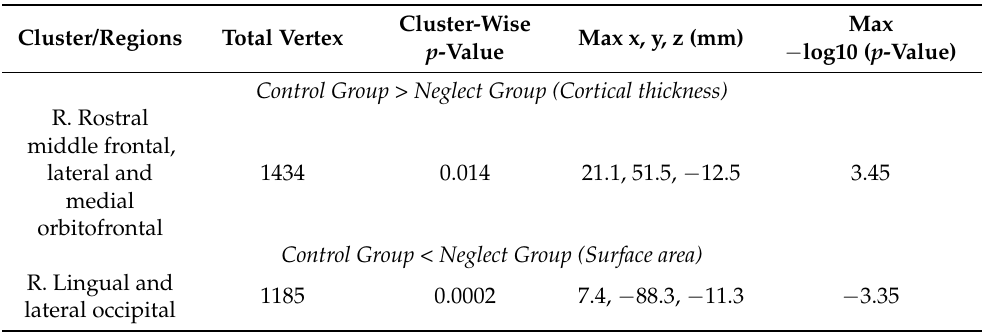
Table 3. Differential cortical features in Neglect versus Control groups. A cluster showing reduced cortical thickness for mothers of the neglect group (CG > NG) was found comprising the rostral middle frontal and orbitofrontal regions. The greater surface area was found in the lingual and lateral occipital gyri for the neglect group (CG < NG). Age, total intracranial volume for surface analyses only, and Psychiatric Disorders were included as nuisance